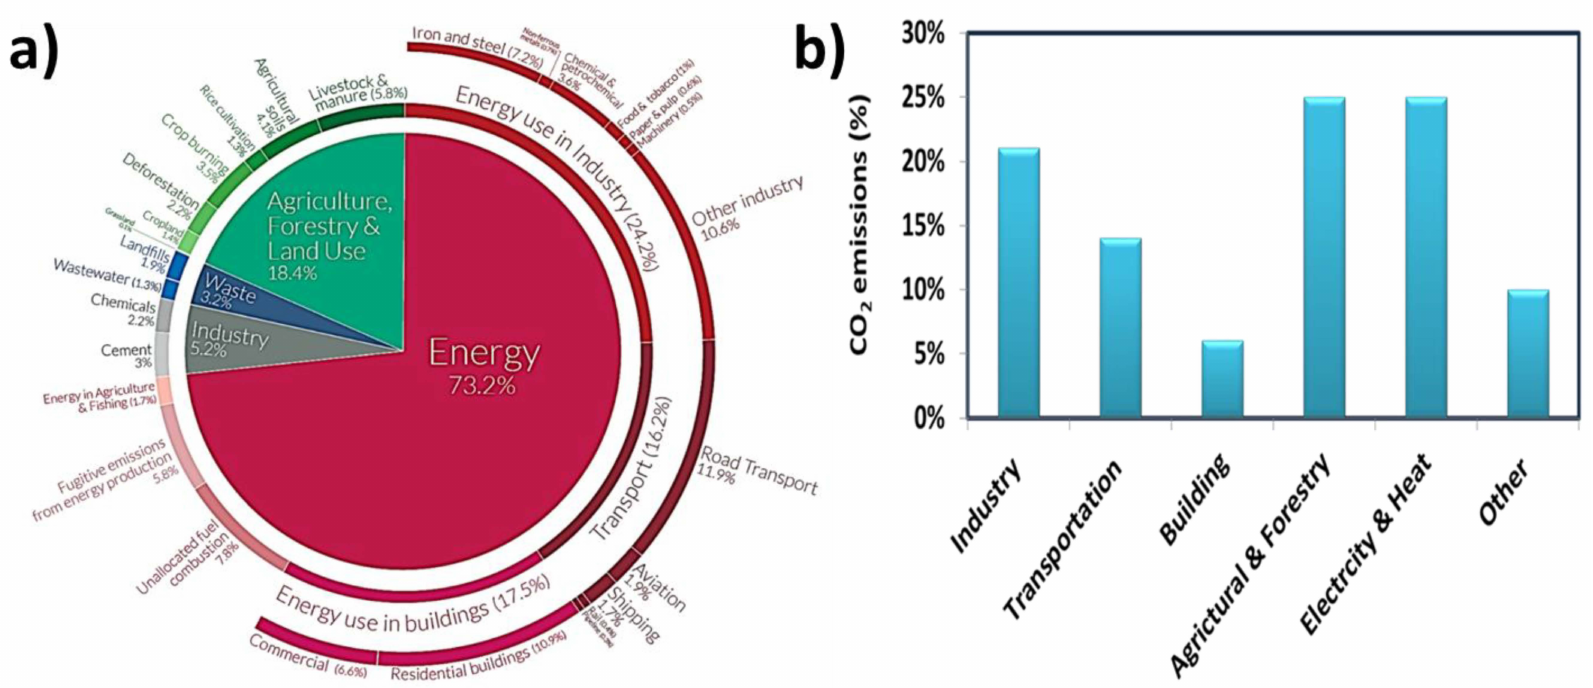
Figure 1. Carbon dioxide emissions by ( a ) various sectors (https://ourworldindata.org/emissions‑by‑sector, accessed on 1 September 2022) and ( b ) economic sectors (https://www.epa.gov/ghgemissions/global‑greenhouse‑gas‑emissions‑data, accessed on 1 September